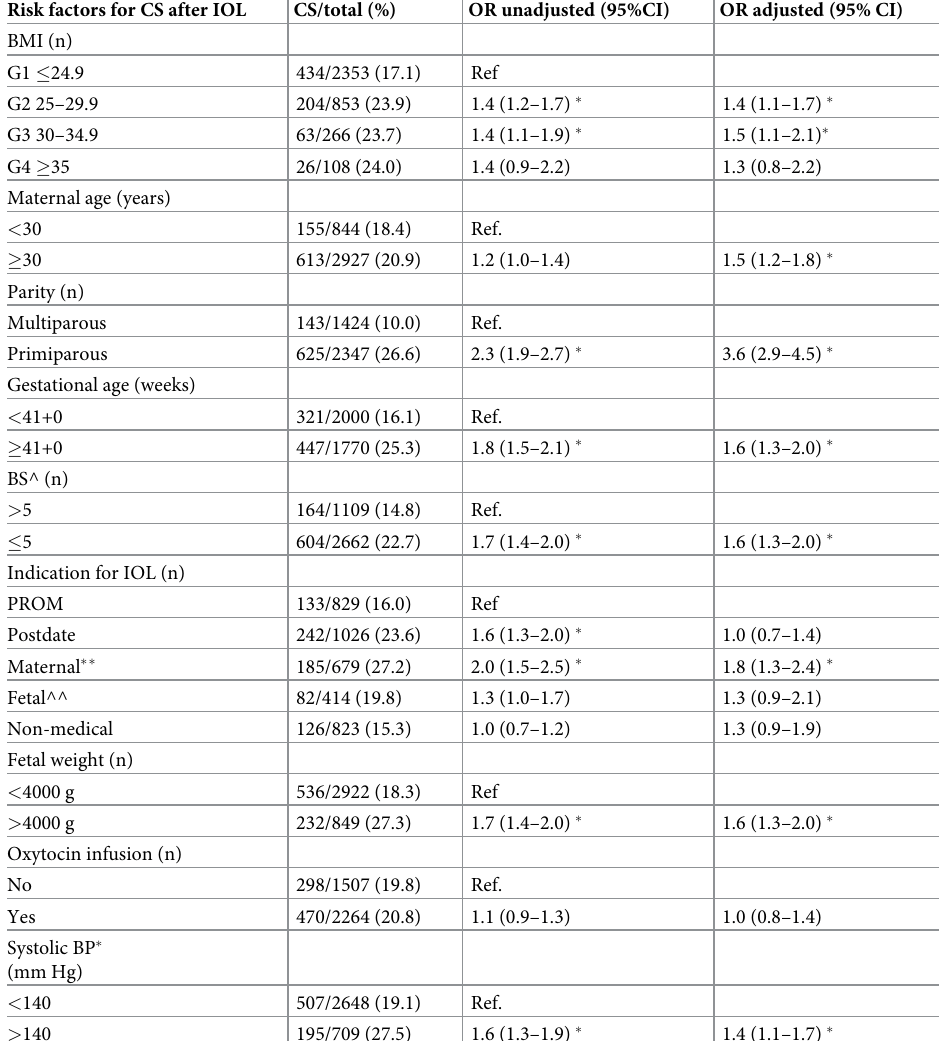
Table 4. Association between potential risk factors for cesarean section (CS) in women who underwent induction of labor (IOL). Data are presented as numbers (%) or mean (standard deviation [SD]). P-values < 0.05 were consid- ered statistically significant �